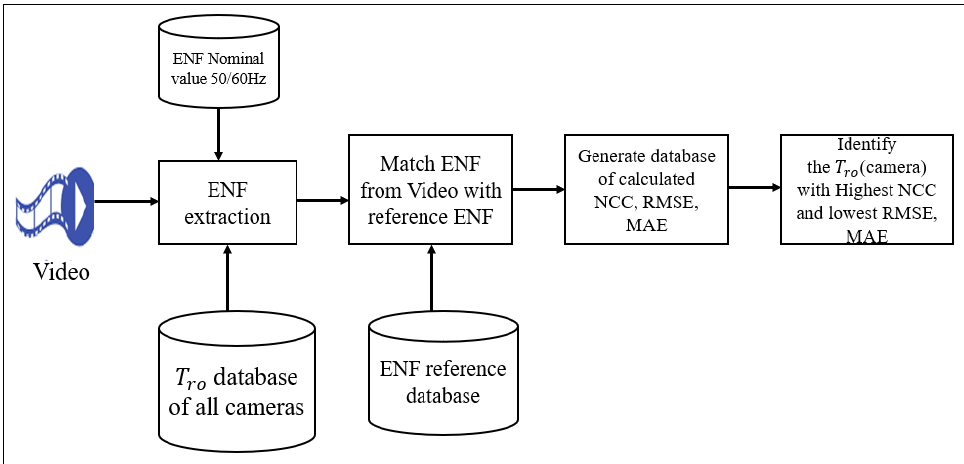
Figure 1. Block diagram of the proposed camera identification approach.